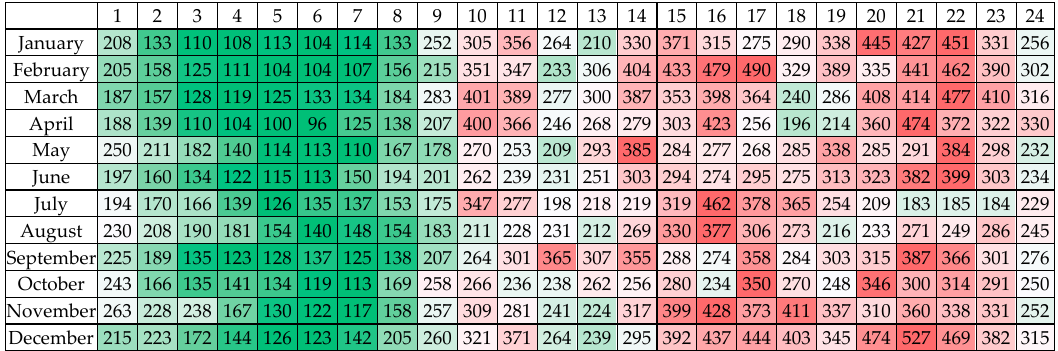
Figure 11. The aggregate profile of average power: Saturdays. (Green: low; White: medium; Red: high).